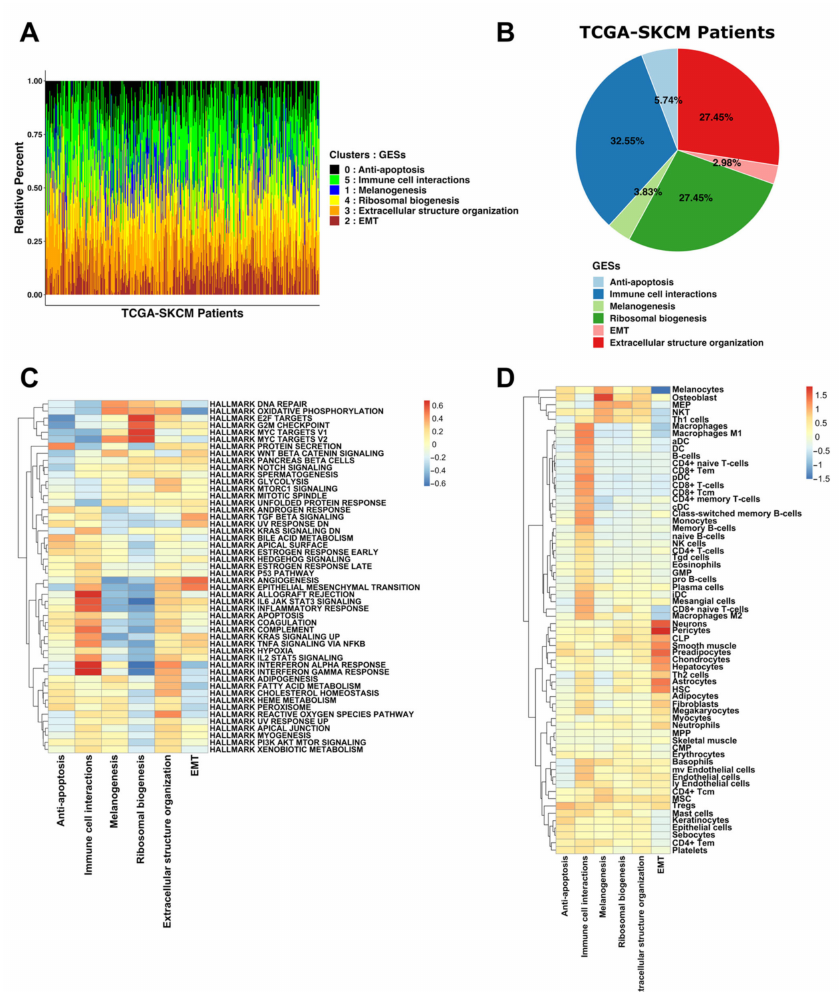
Figure 4. Classification of TCGA-SKCM patients based on the GESs determined by the scRNA-seq analysis. ( A ) Stacked bar chart showing the fractional compositions of the melanoma cells of the 6 scRNA melanoma cell clusters (GESs) in TCGA-SKCM samples. ( B ) A pie chart showing the frac- tions (expressed in percentages) of the melanoma GESs in the deconvoluted TCGA-SKCM samples. ( C , D ) Heatmaps showing the Hallmark GSEA ( C ) and cell-type enrichment ( D ) in the identified TCGA